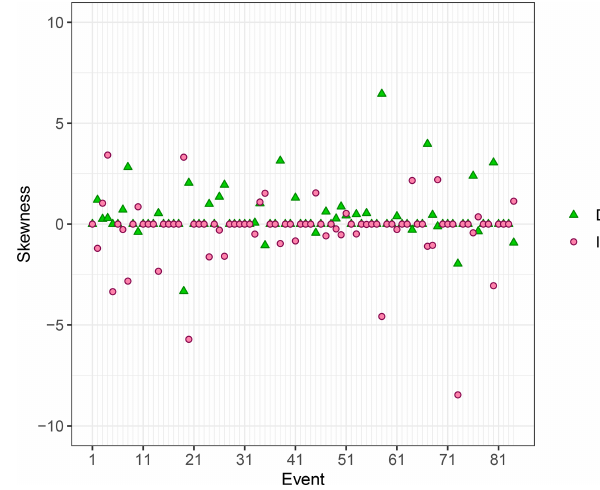
Figure 7. Skewness of the distributions of D and I for each